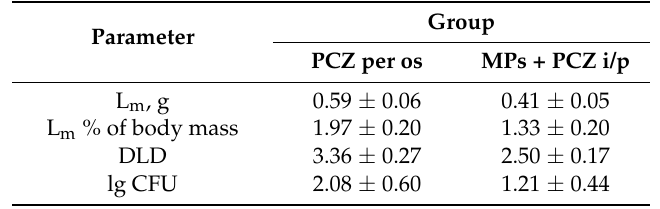
Table 2. Degree of lung involvement and insemination in survived mice. Abbreviations: L m —mass of the lung; DLD—degree of macroscopic drug damage (see Section 2); CFU—colony-forming unit; lgCFU—index of lung bacilli